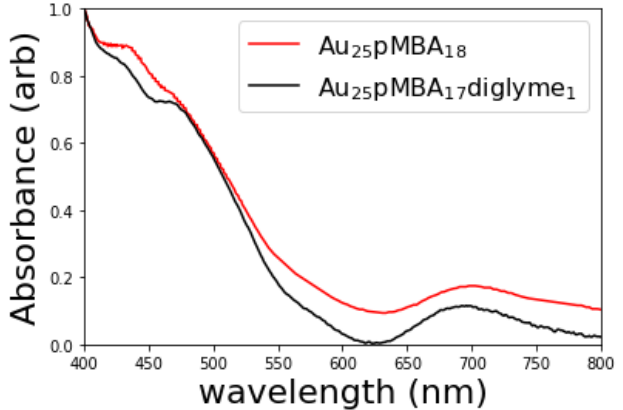
Figure 2. UV–VIS for Au25pMBA 17 diglyme1 (black) is comparable to the UV–VIS spectrum for Au25pMBA 18 (red), reproduced from [19].